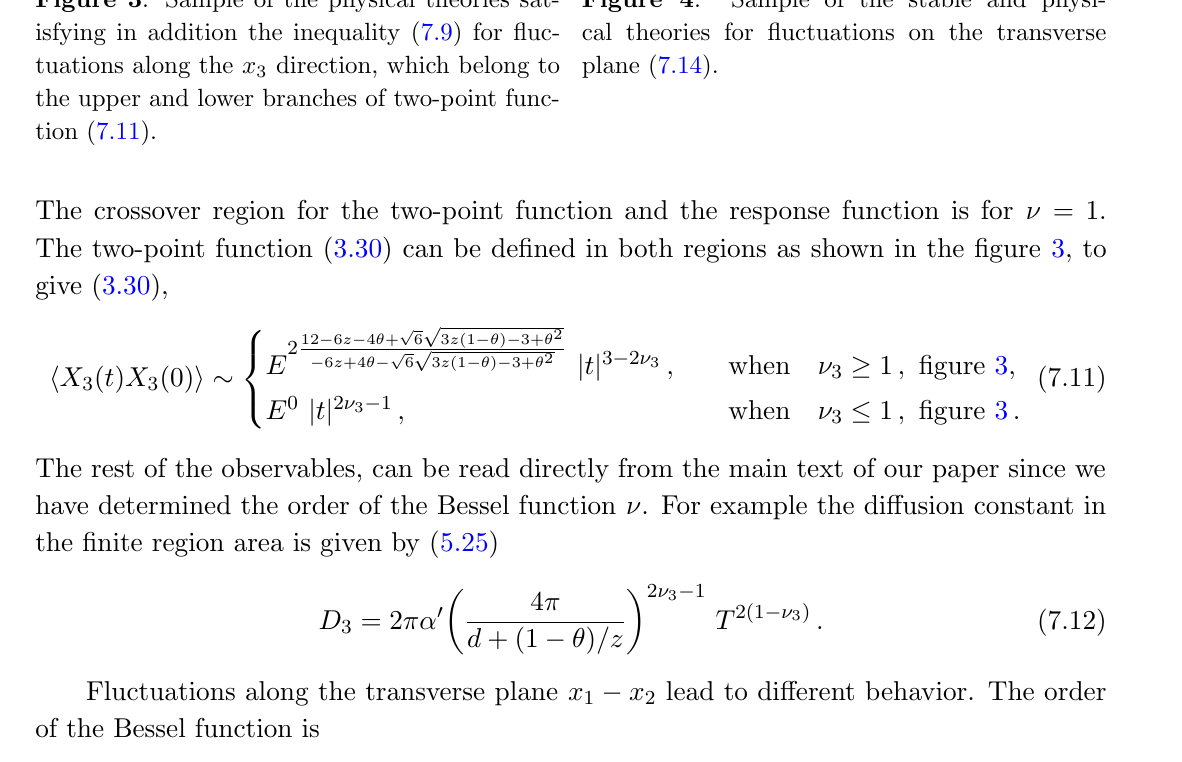
Figure 4 . Sample of the stable and physi- cal theories for (cid:13)uctuations on the transverse plane